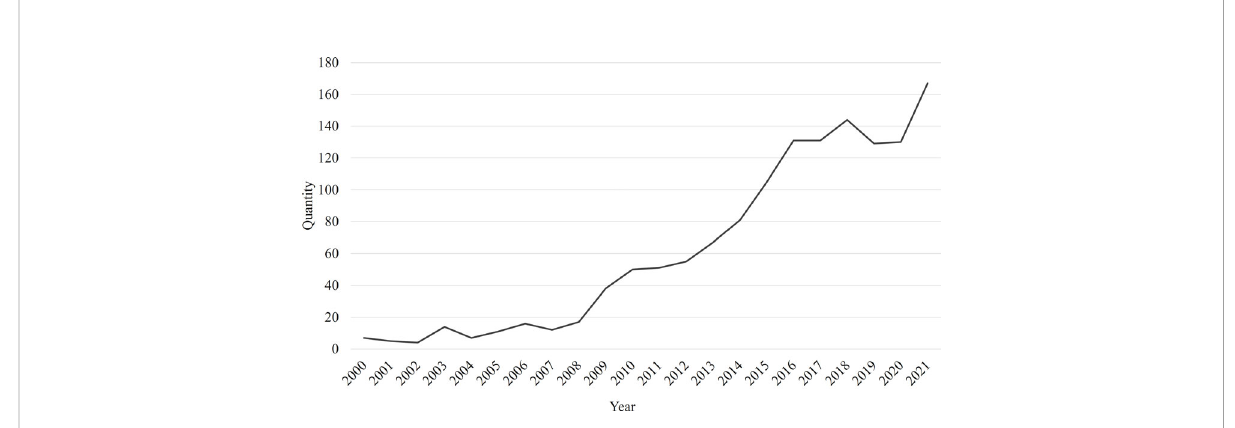
FIGURE 1 Trends of publications on Apostichopus japonicus -related research from 2000 to